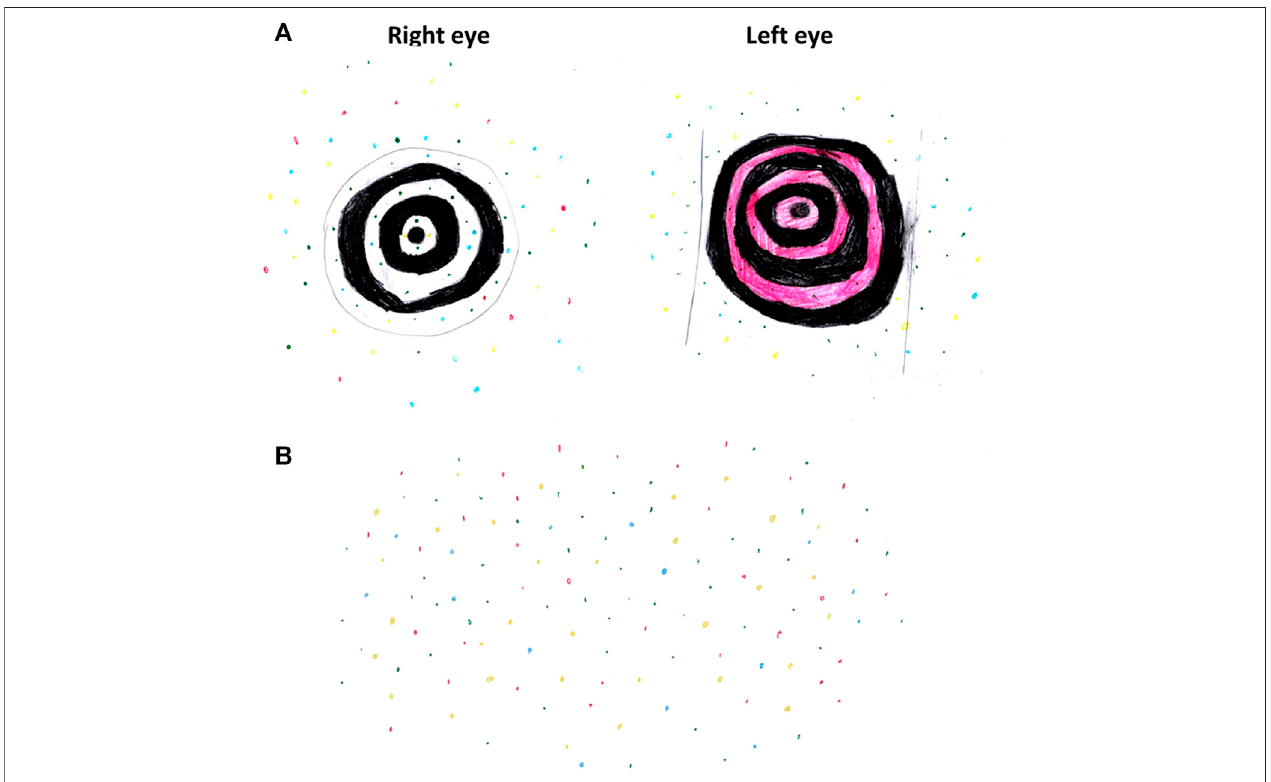
FIGURE 1 | The patient ’ s drawing at 8 years old describing her visual experience. (A) Black-and-white or coloured swirls with colourful dots. (B) Colourful dots involving the entire visual fi eld.